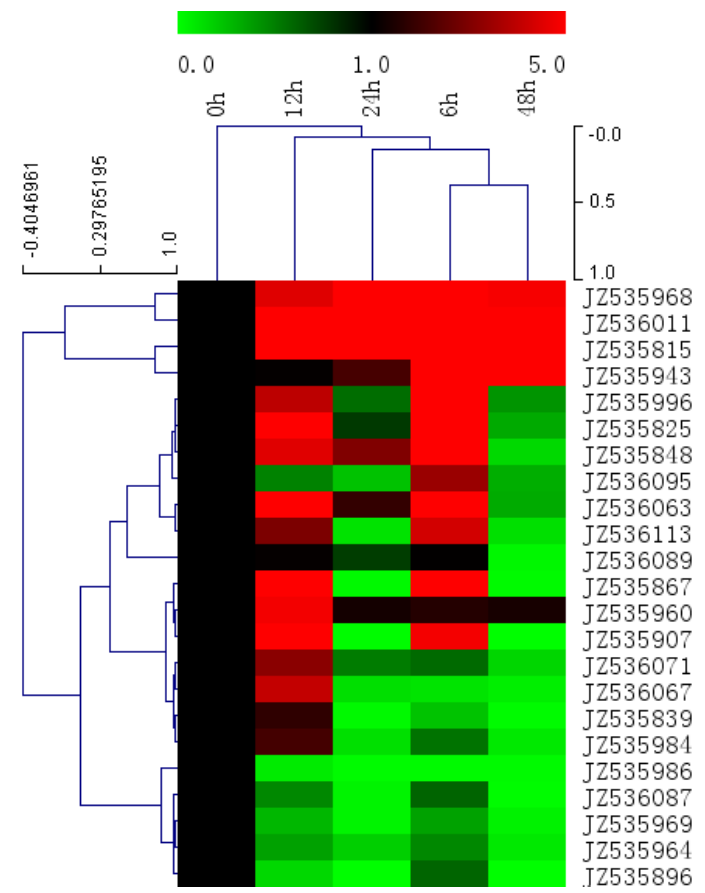
Figure 6. Hierarchical cluster of 23 potentially salt stress-responsive genes in transcript abundance with different times of 400 mM NaCl treatment (0, 6, 12, 24, and 48 h). Each gene is represented by a single row of colored boxes, and a single column represents different times with NaCl treatment. Induction (or repression) ranges from pale to saturated red (or green) with a fold change scale bar (in log2) shown up the